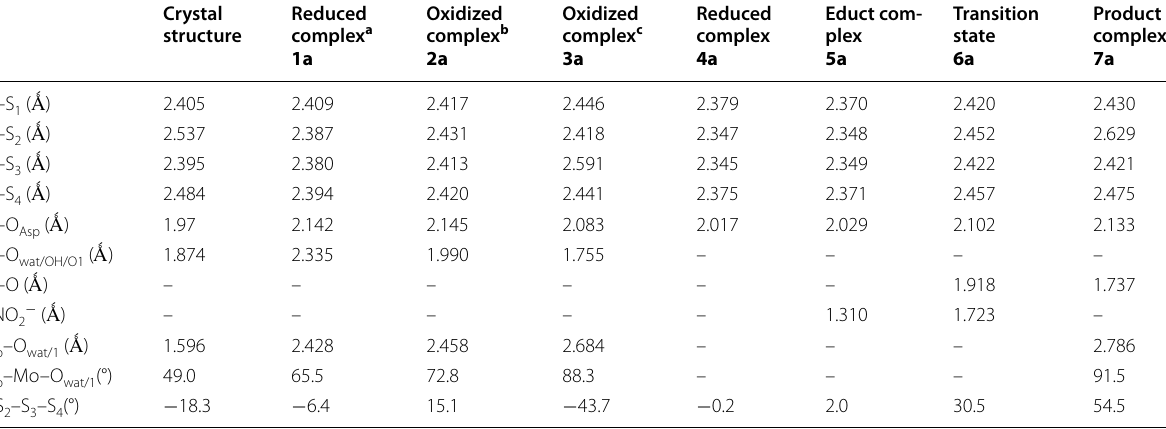
a Water containing reduced complex b Hydroxide containing oxidized complex c Oxygen containing oxidized complex